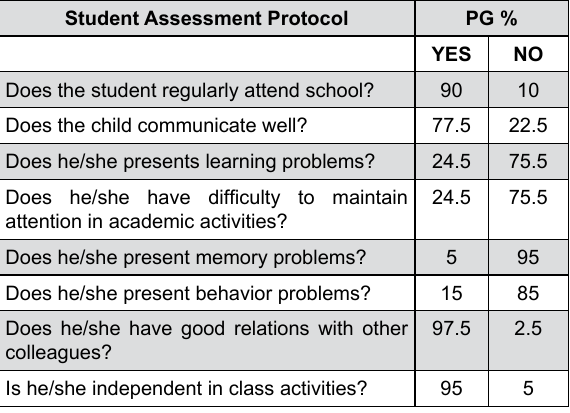
Student Assessment Protocol